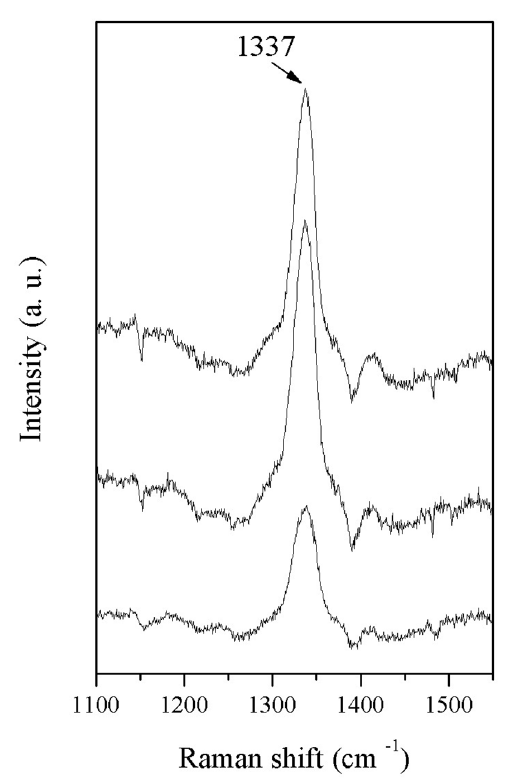
Figure 7. Raman scattering spectrum of sample “D”. A deviation from the natural diamond (1332 cm -1 ) of 5 cm -1 is an indicative signal of high internal residual stress of the film. Factors such as deposition time and surface preparation can explain the high internal stress of the